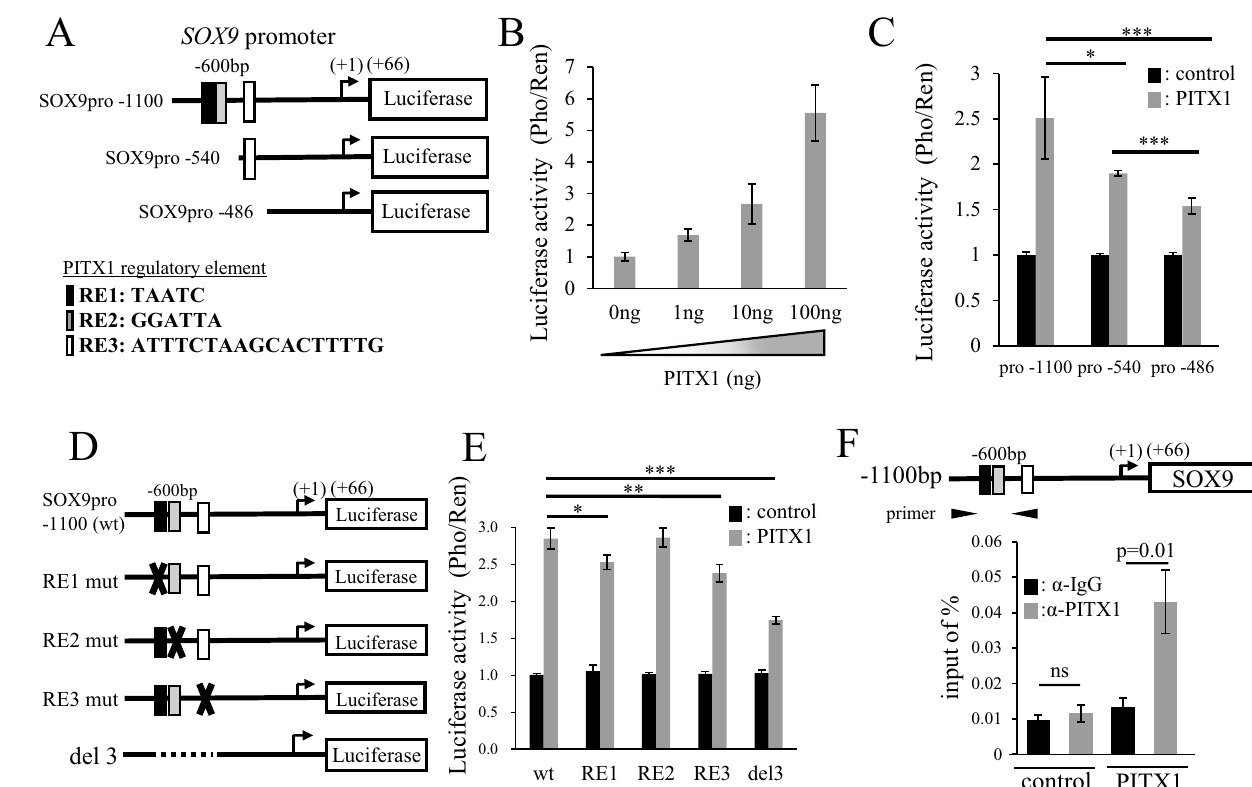
Figure 3. Upregulation of SOX9 promoter transcriptional activity by PITX1. ( A ) The schematic drawing shows the position of the truncation site of each SOX9 reporter plasmid. Black, gray and white boxes indicate PITX1 regulatory elements (RE). ( B ) PITX1 enhanced relative luciferase activity in a dose-dependent manner. The firefly luciferase activity (Pho) was standardized using Renilla reniformis luciferase activity (Ren) from co-transfected pGL4.70. Luciferase activity in empty-vector-transfected cells (PITX1:0ng) was arbitrarily set at 1. Data are presented as means ± S.D. for three independent experiments. ( C ) PITX1 expression vectors were co-transfected into the human melanoma cell line A2058 with reporter plasmids containing a full-length promoter (SOX9pro − 1100), or a truncated SOX9 promoter region in which RE sites in the SOX9 promoter region partly or fully eliminated (SOX9pro − 540 and SOX9pro − 486). Luciferase activity in empty-vector- transfected cells was arbitrarily set at 1. Data are presented as means ± S.D. for three independent experiments (*P < 0.05, ***P < 0.001). ( D ) The schematic diagram shows the luciferase reporter plasmids that encode wild- type and RE mutated versions of the SOX9 promoter region (RE1 mut, RE2 mut and RE3 mut). The cross mark represents mutation. The del3 reporter plasmids are deleted of RE1, RE2 and RE3 in the SOX9 promoter region. ( E ) PITX1 expression vectors were co-transfected with reporter plasmids containing the wild-type, RE-mutated, or deleted versions of the SOX9 promoter. Luciferase activity in empty-vector-transfected cells was arbitrarily set at 1. Data are presented as means ± S.D. for three independent experiments (*P < 0.05, **P < 0.01, ***P < 0.001). ( F ) Schematic diagram showing the SOX9 promoter and three boxes indicating PITX1 binding regions (upper panel). The black arrows indicate qPCR primers for the RE region in the SOX9 promoter based on a ChIP assay. ChIP assay of RE regions in the SOX9 promoter, showing enrichment with PITX1 antibody compared with IgG controls in A2058 clones. Anti-IgG antibody was used as a negative control. Input represents qPCR for the SOX9 promoter DNA before immunoprecipitation. The data represent the ratio of the target fragment to the input DNA. Bars correspond to means ± S.D. for three independent experiments (P = 0.01, ns: not significant). All the bar graphs were created using